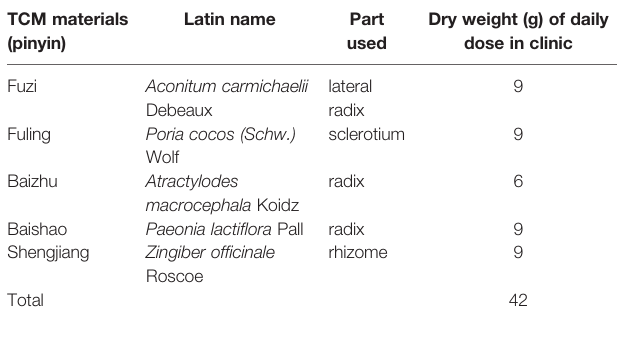
TABLE 1 | The composition of Zhen-wu-tang